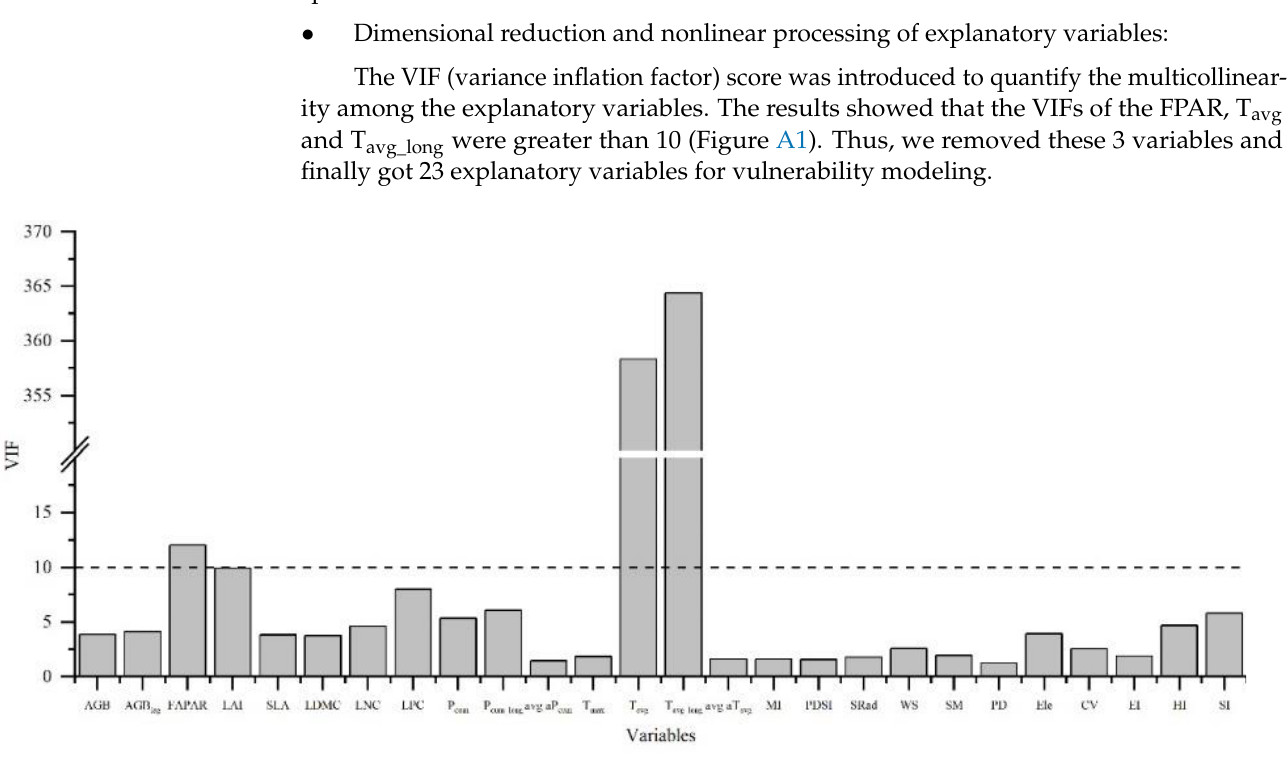
Figure A1. Multicollinearity (VIF) among explanatory variables.